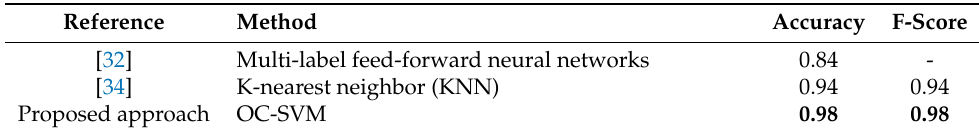
Table 11. Comparison between different DNS tunneling techniques using the labeled DNS exfiltration dataset [32].